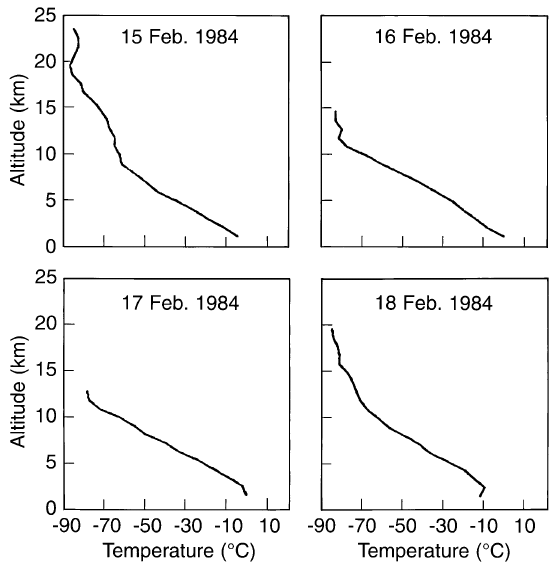
Fig. 3. Temperature profiles measured by balloons on 15, 16, 17, and 18 February 1984 above Murmansk